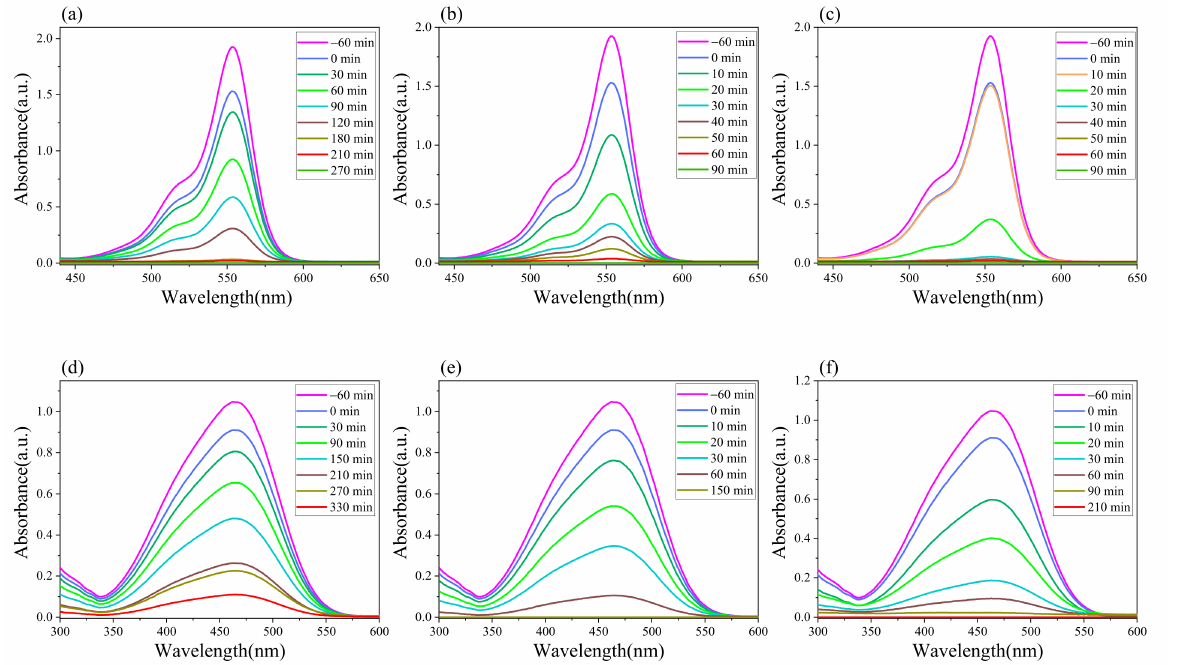
Figure 5. The absorption spectra of Rhb and MO under different catalytic conditions: ( a ) Rhb (g-C 3 N 4 ); ( b ) Rhb (g-C 3 N 4 /H 2 O 2 ); ( c ) Rhb (g-C 3 N 4 /Na 2 S 2 O 8 ); ( d ) MO (g-C 3 N 4 ); ( e ) MO (g-